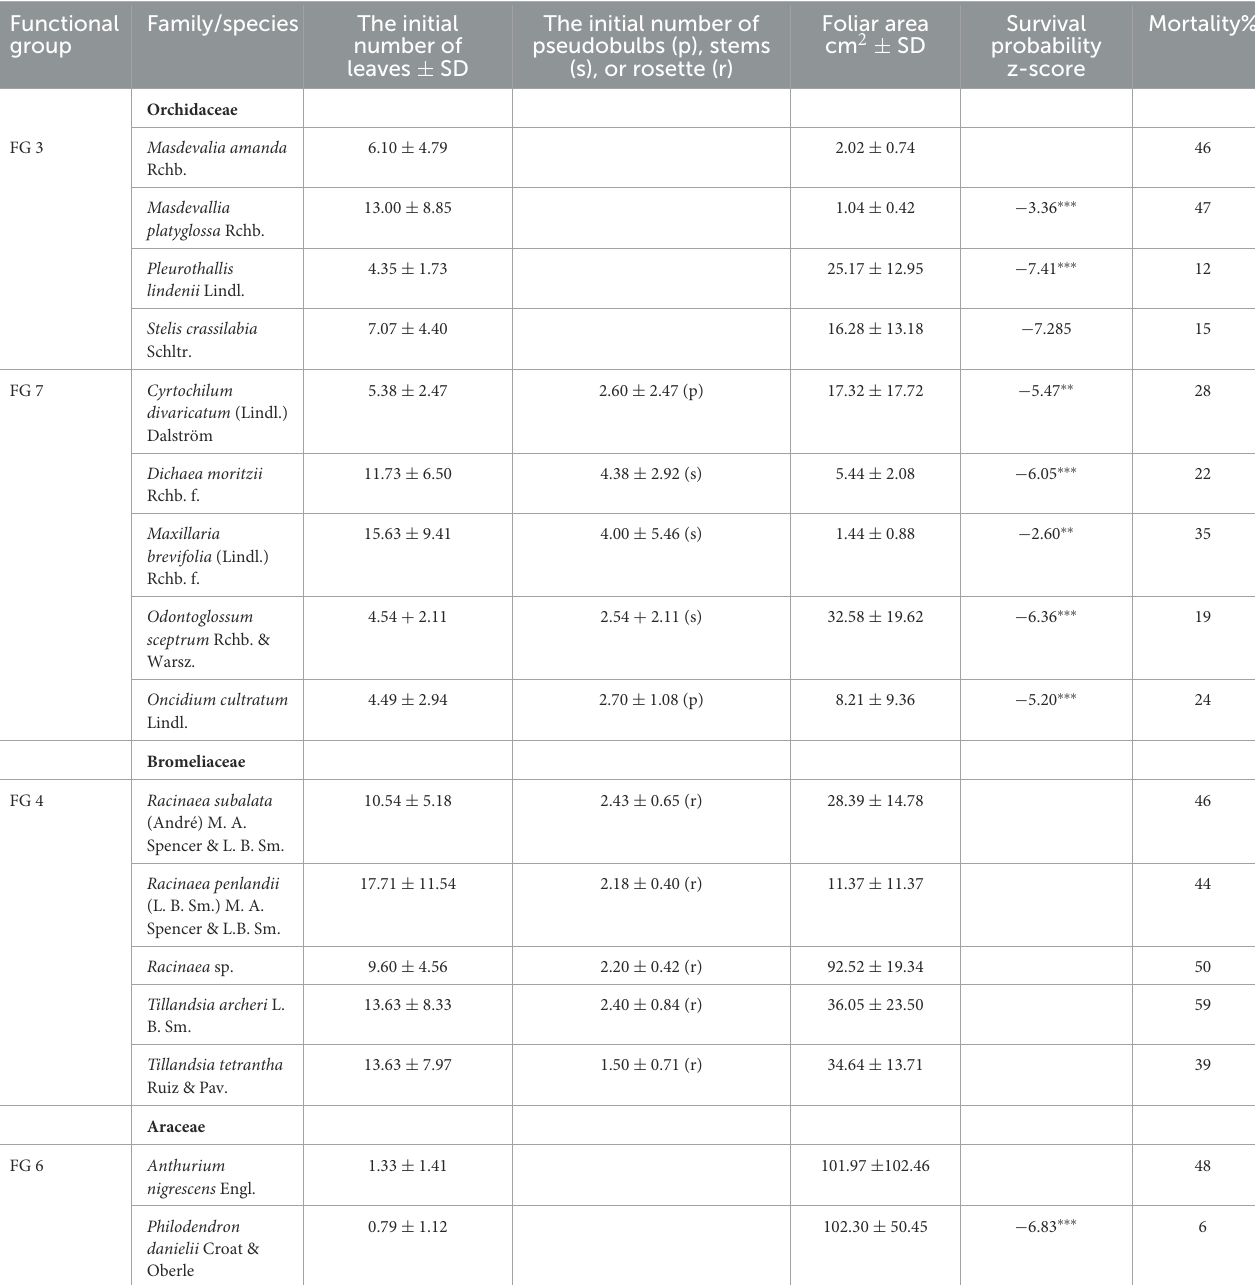
TABLE 1 Species functional group [ sensu Agudelo et al., 2019], initial number of leaves or/and pseudobulbs (p), stems (s) or rosette (r), survival probability z-score, and percentage of mortality at the end of the 8th year ∗ . Functional group